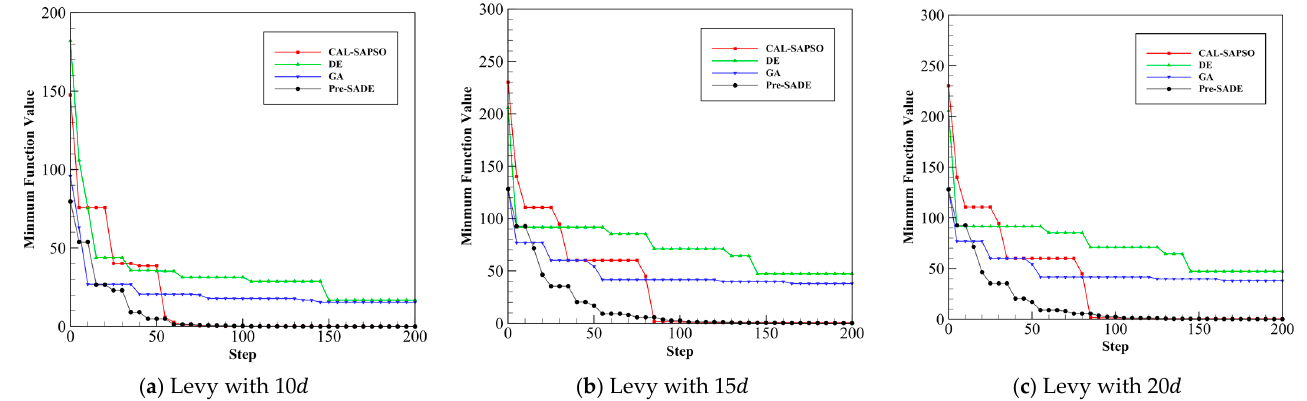
Figure 5. Convergence history of CAL-SAPSO, DE, GA, and pre-SADE on the Levy of ( a ) 10 d , ( b ) 15 d , and ( c ) 20 d .